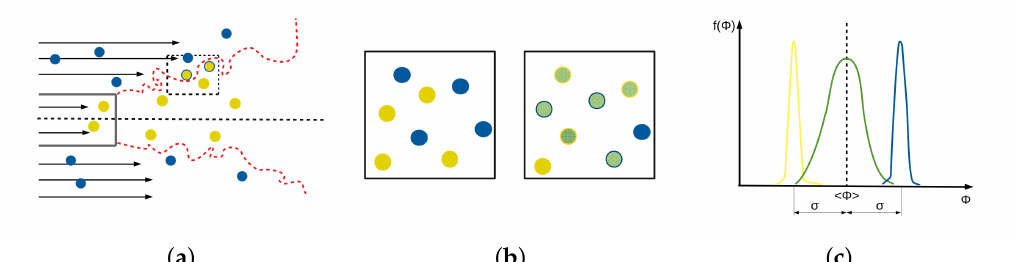
Figure 3. A schematic plot of the mixing process downstream the nozzle orifice: ( a ) stochastic particles in the two streams at the shear layer; ( b ) zoom-in of a fluid material volume: the initial stage (not micromixed, blue and yellow particles) and a later stage (partly micromixed, greenish particles); ( c ) evolution of the scalar PDF: the initial stage (bimodal distribution: blue and yellow parts) and a later stage (green